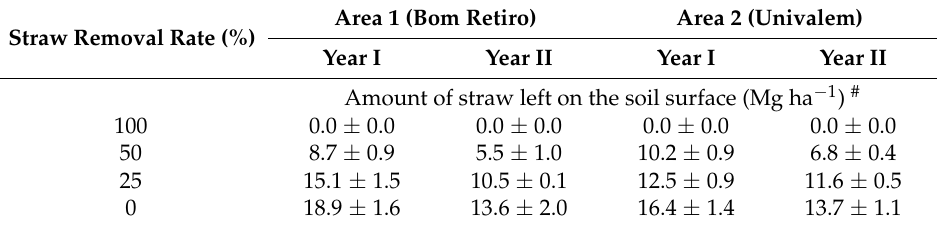
Table 2. Amount of sugarcane straw left on soil surface after each treatment in the first and second years in each experimental area.